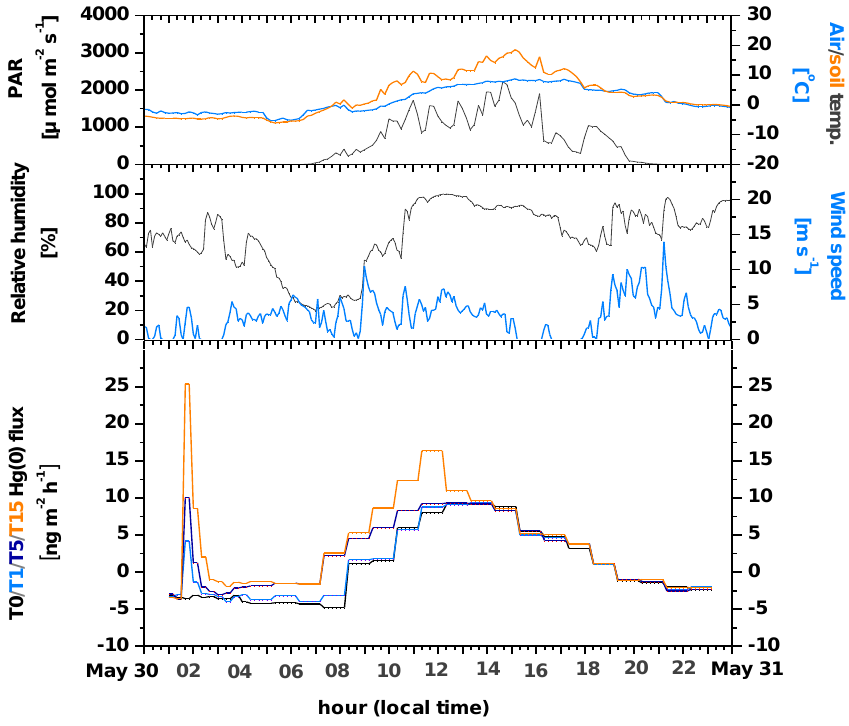
Figure 4. Temporal variation in Hg(0) flux over four soil plots with different treatment of water addition (T0: 0mm treatment; T1: 1mm treatment; T5: 5 mm treatment; and T15: 15mm treatment) and the environmental